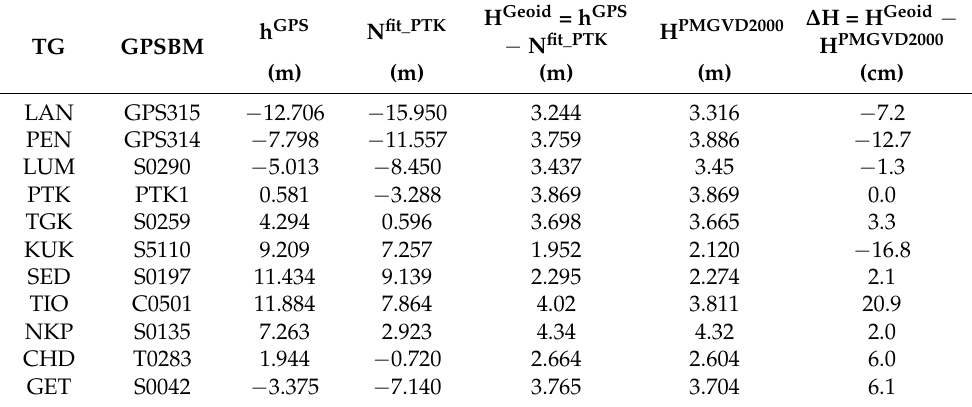
Table 11. Result of GPS levelling by fitting PMGeoid2022 to PMGVD2000 datum at Port Klang tide gauge station, revealing local datum offsets, subsidence, and levelling error propagations.